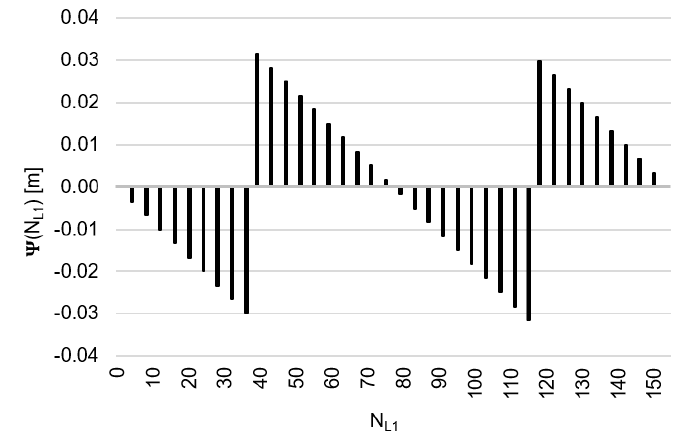
Figure 5. Behavior of the function Ψ(𝑁 (cid:3013)(cid:2869) ) (cid:3015)